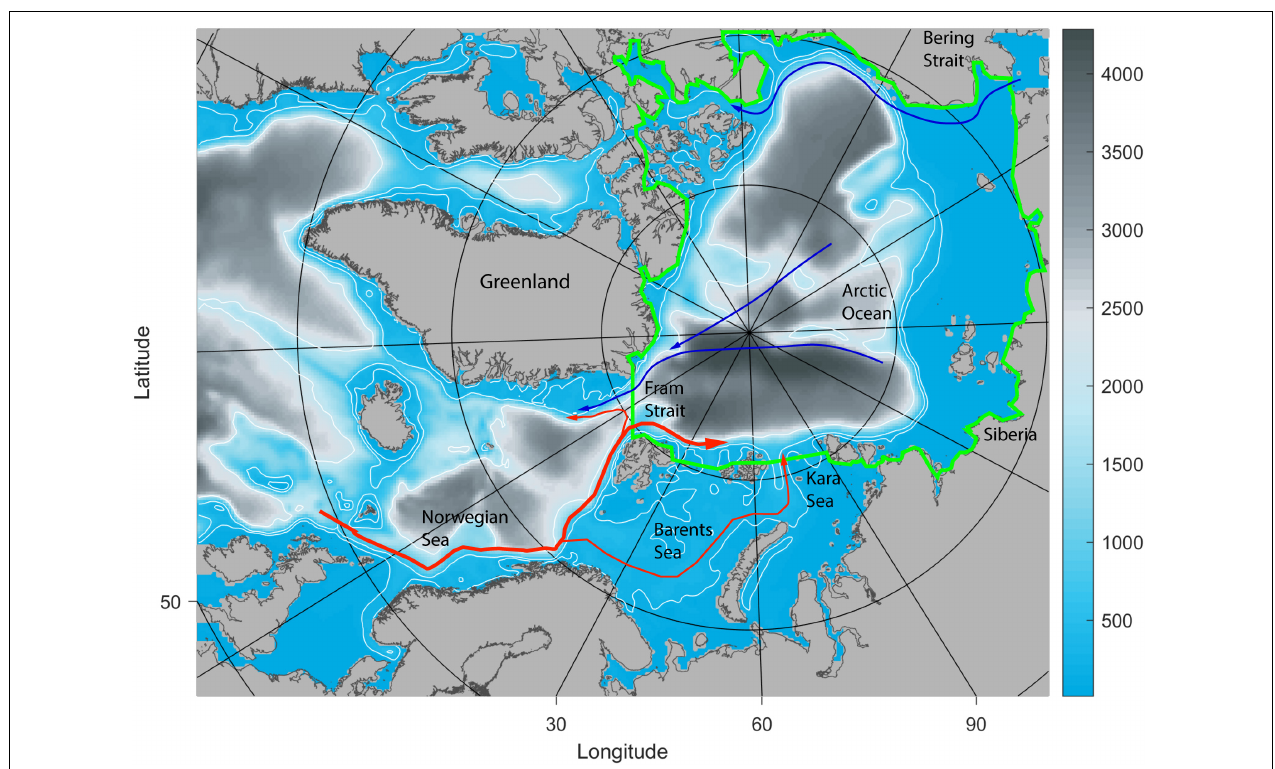
FIGURE 1 | Model domain with depths (m). The relatively warm Atlantic inflow (red) enters the Arctic Ocean through the Fram Strait and the Barents and Kara Seas. Pacific water enters through the Bering Strait. Surface Arctic water (blue) leaves the Arctic through the Canadian Archipelago and Fram Strait. The green polygon shows the area that is analyzed in this